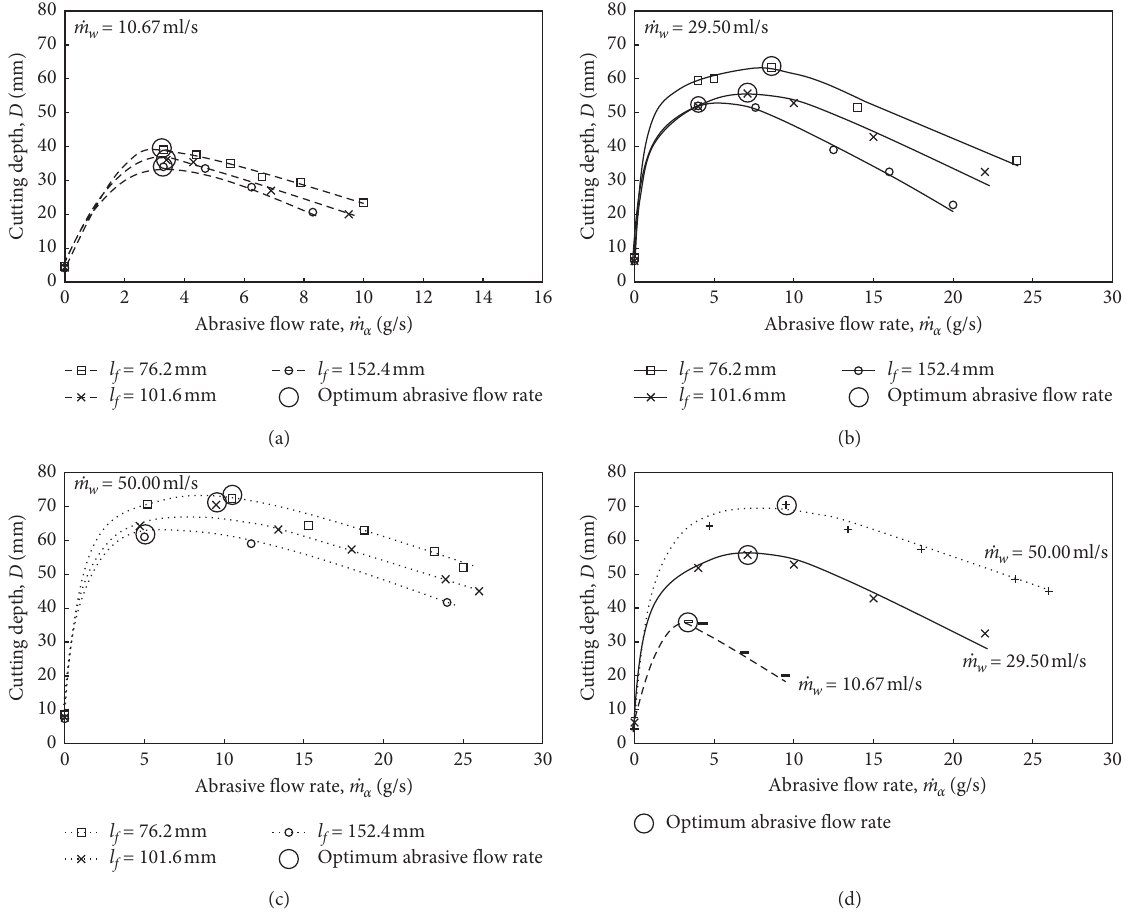
Figure 8: Effects of the focus length on the cutting depth at a constant d and (c) 50.00ml/s and (d) the total water flow rate with l f � 101 . 6